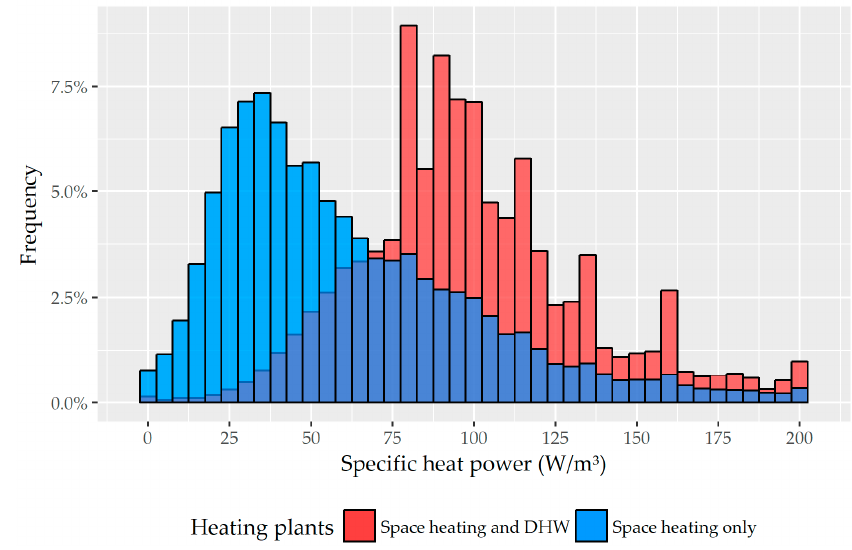
Figure 6. Distributions of nominal and measured (combustion) efficiency.